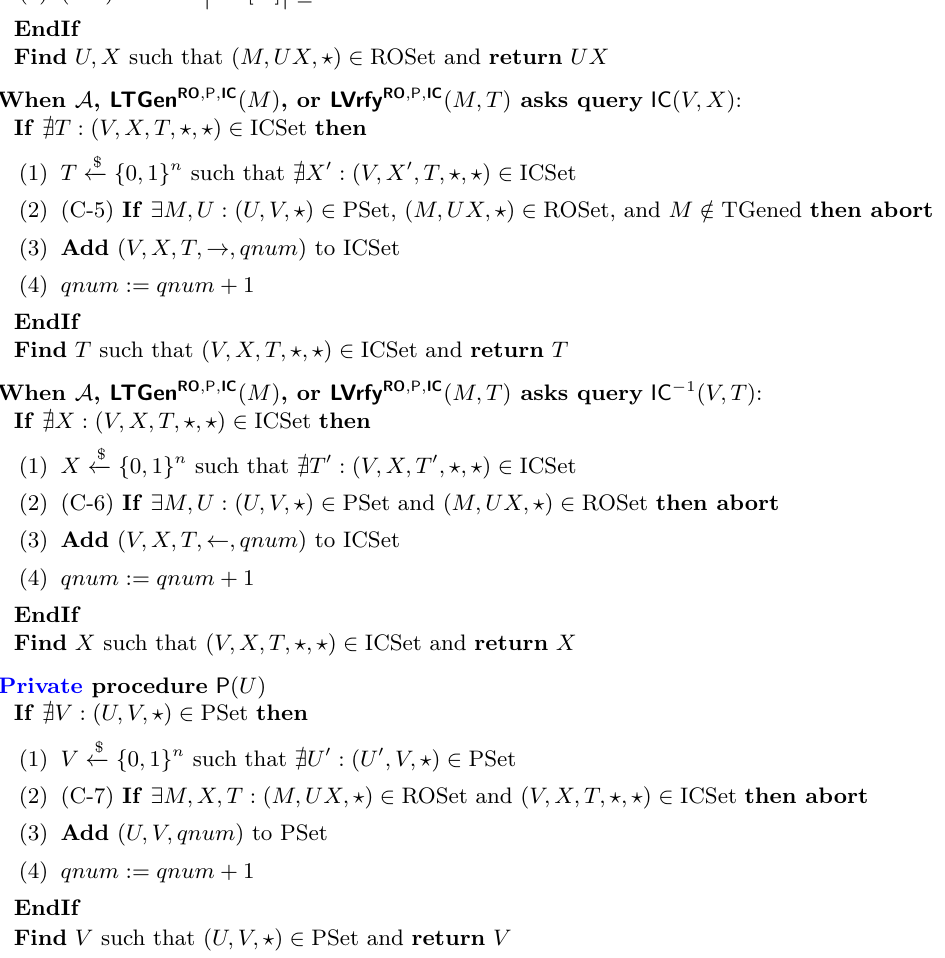
Figure 5: Security game capturing the interaction between A and the idealized tag generation and verification oracles of RHM